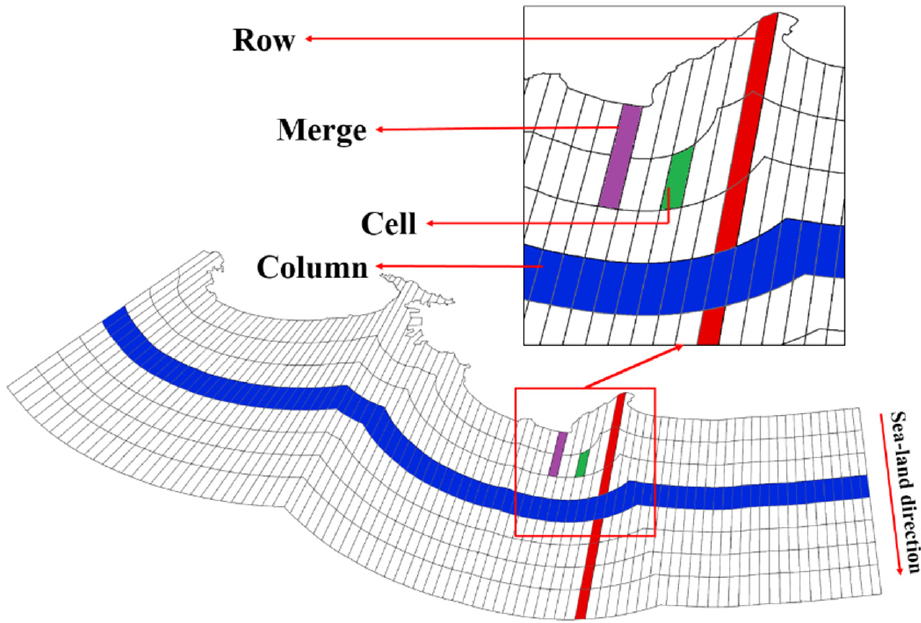
Figure 2. Schematic diagram of the grid division. After dividing grid samples, the grid samples were overlaid with land use change vector data to obtain the land use change rate of each grid unit. The LDI of the grid unit was divided into four levels using the Jenks natural breaks method: weak (rate of change < 16.93%), medium (16.93% ≤ rate of change < 38.26%), strong (38.26% ≤ rate of change < 62.88%) or extremely strong (62.88% ≤ rate of change). To reduce the data redundancy and maintain the validity of the sample information, the grid units with the same LDI level were merged into one unit (as shown in Figure 2). After merging, the distribution of LDI in three interval periods was obtained and is shown in Figure 3. A set of sample sequences included the units along the same direction perpendicular to the shoreline, and the sample set was used to establish the decision table of the association